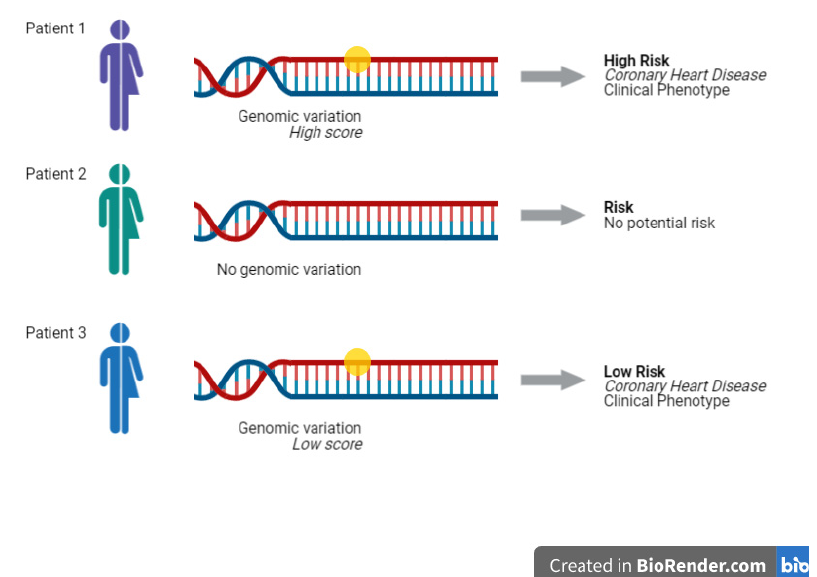
Figure 1. Polygenic Risk Scores test can predict the risk of developing a disease according to the score of the genomic variation investigated. Image created with BioRender.com (accessed on 1 March 2021).